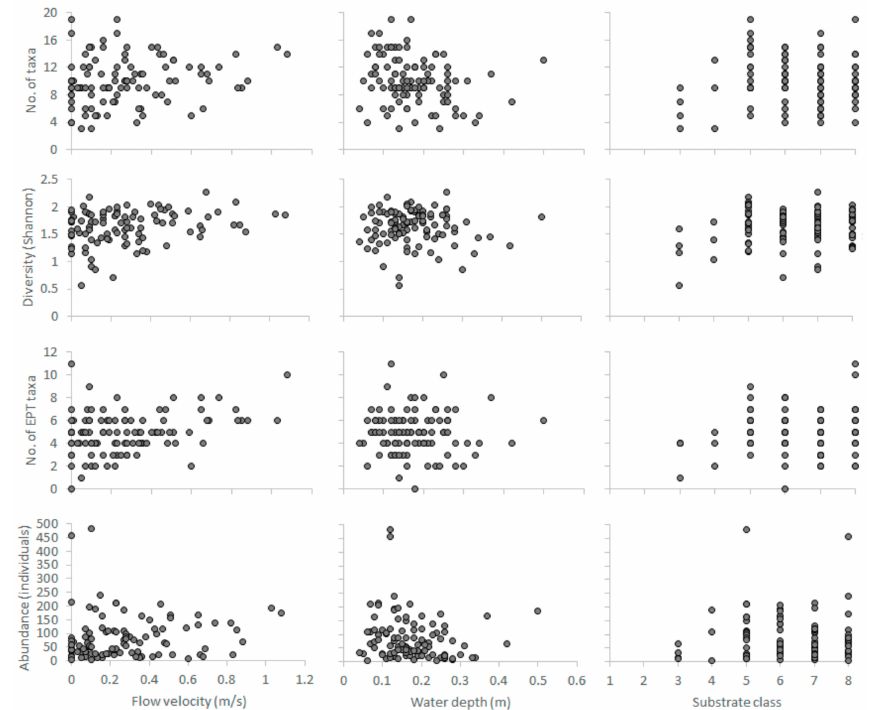
Figure A5. Hydroecological relationships developed from the RM1-2-type samples ( n = 100) of the benthos-GR dataset between the three abiotic predictors and the four selected biotic response variables-metrics. Substrate classes; 1: Silt, 2: Sand, 3: Fine gravel, 4: Medium gravel, 5: Large gravel,